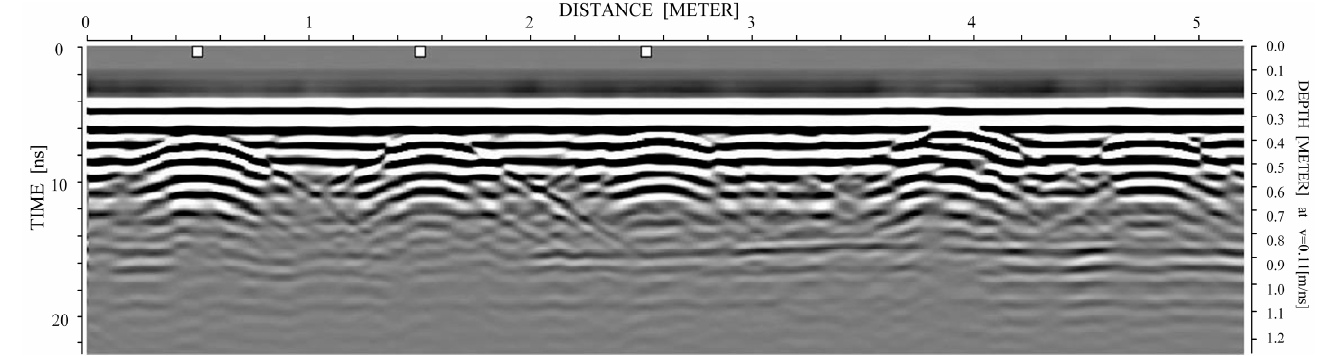
Figure 3. Ground penetrating radar image with direct wave front removed.